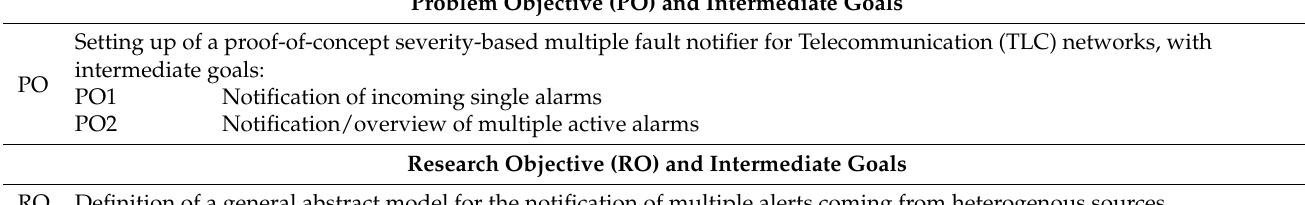
Table 2. Problem and research